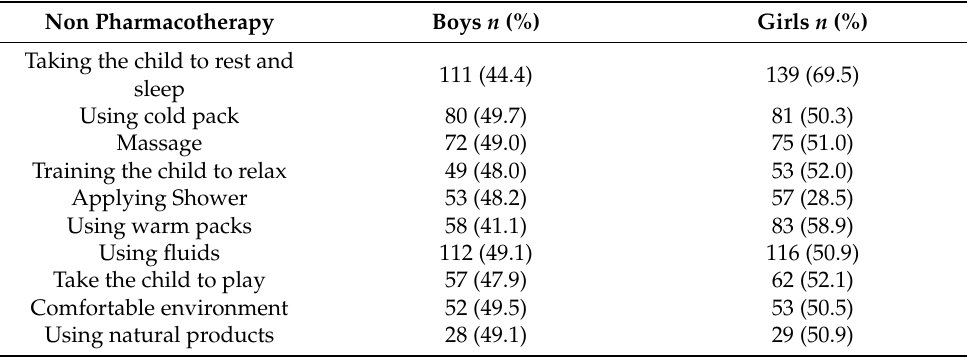
Table 3. Non-pharmacological methods used by mothers at